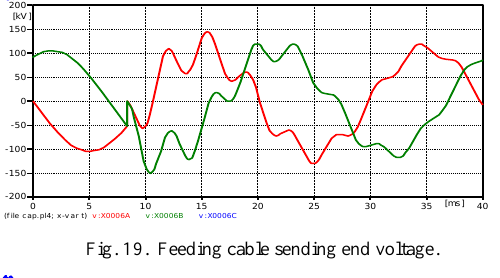
Fig. 19. Feeding cable sending end voltage.